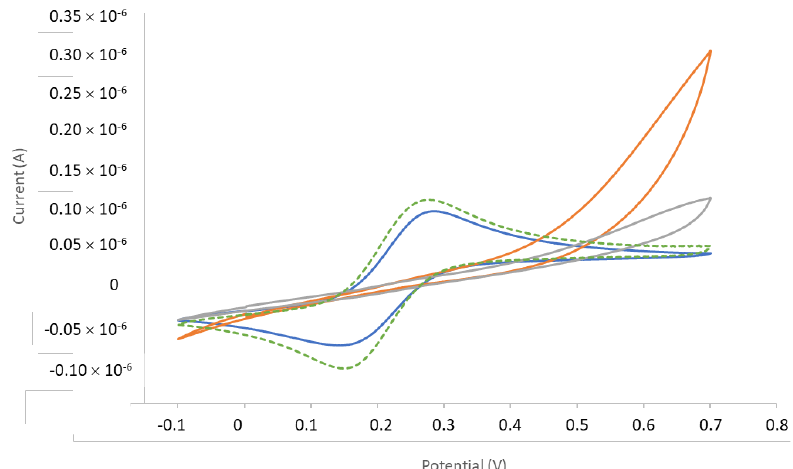
Figure A7. Cyclic voltammograms (CVs) of the ferri/ferrocyanide couple on a bare Au electrode (dotted green line), functionalized with 1-azido-6-thiohexane (orange line) and after coupling of DO3A-alkyne on the 1-azido-6-thiohexane-functionalized electrode (grey line). The blue CV corresponds to a bare Au electrode let to react on DO3A-alkyne under the same conditions as the 1-azido-6-thiohexane-functionalized electrode. Electrolyte: 0.1 M KCl; 0.01 M Fe(CN) 63- /Fe(CN) 64- as potassium salt. Au wire electrodes ( = 1 mm).